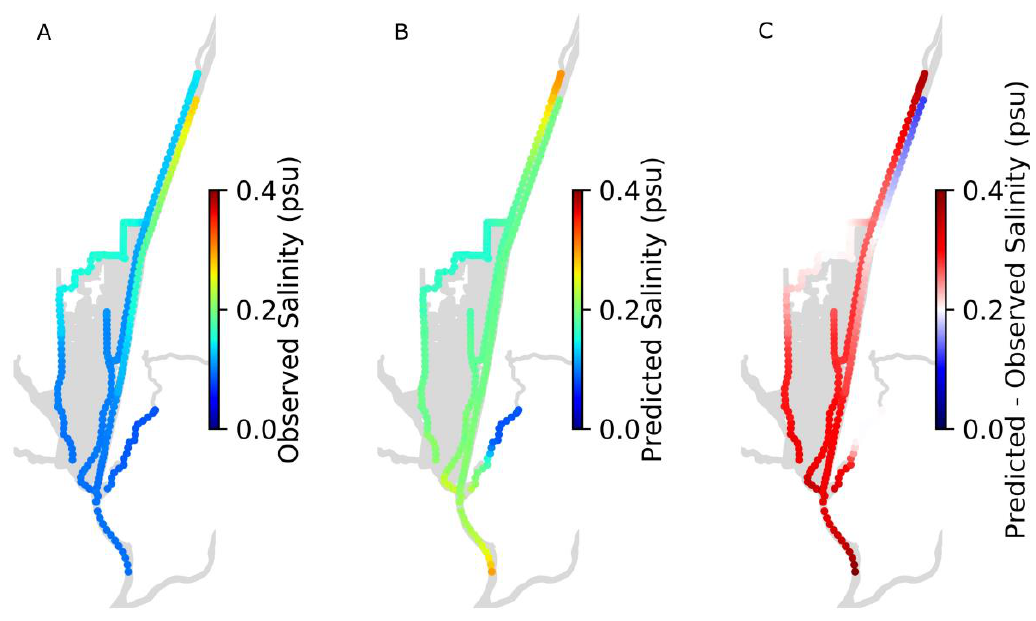
Figure 5. Observed (solid lines) and predicted (dashed lines) tidally-averaged salinity at four stations along the axis of the northern San Francisco Estuary. Line colors of panel ( A ) correspond to marker colors of panel ( B ).